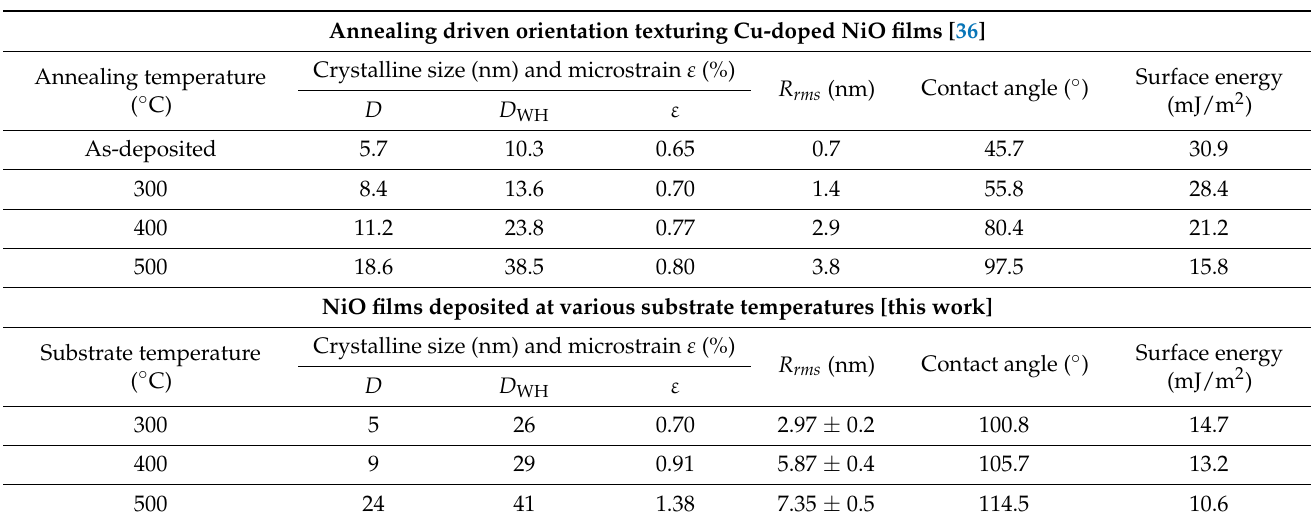
Table 1. The structural and surface characteristics of the annealing-driven orientation textured and the present substrate-temperature-induced textured NiO